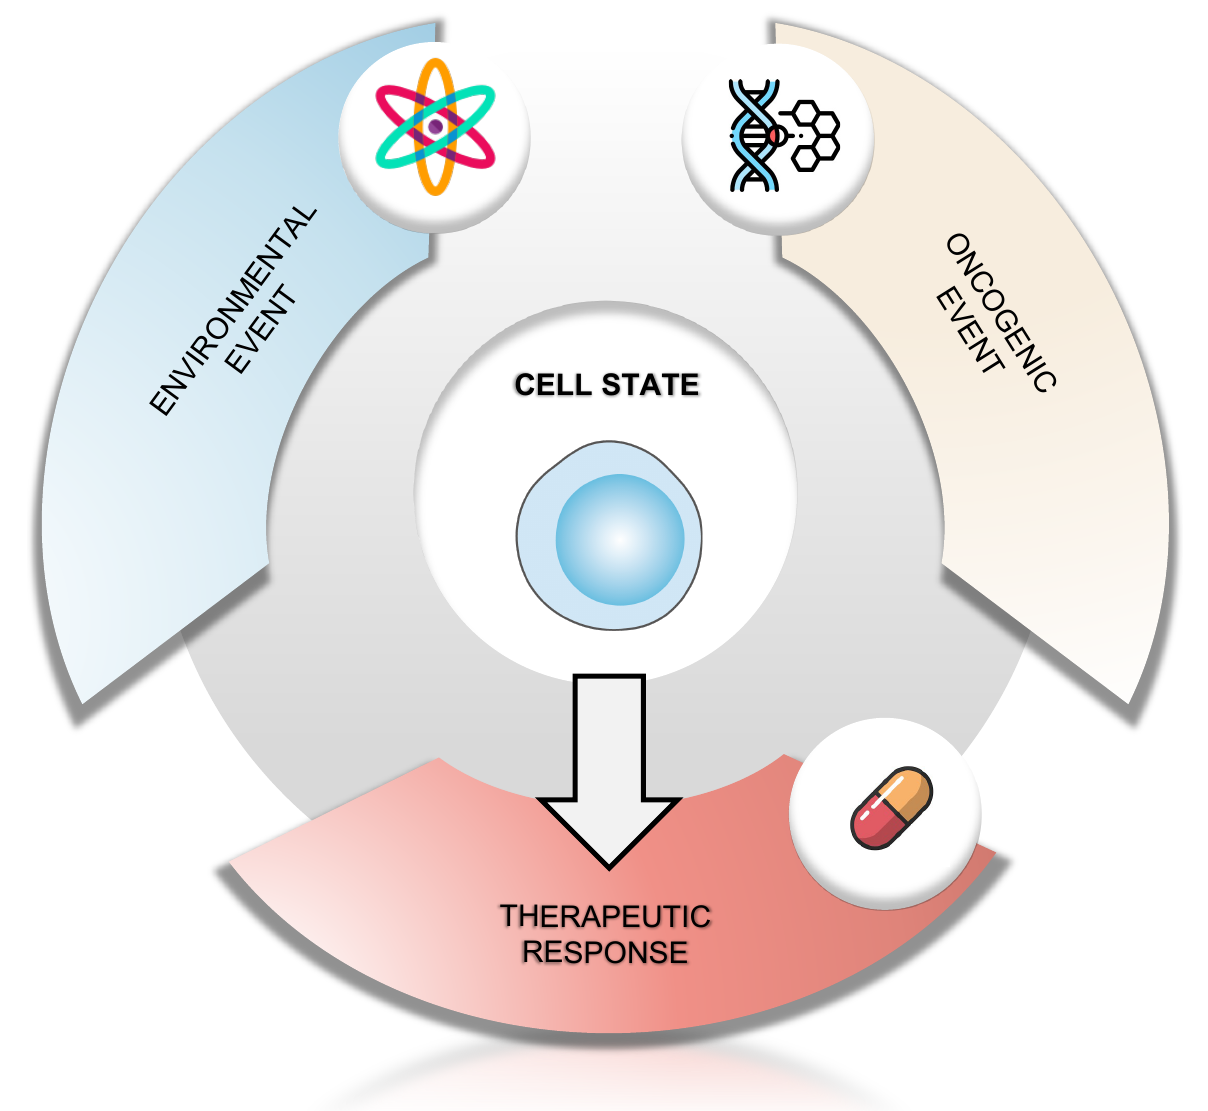
Figure 3. The therapeutic response is conditioned by the combination of the oncogenic event and the environmental factors at the origin of the tumor transformation, and the cellular context in which they